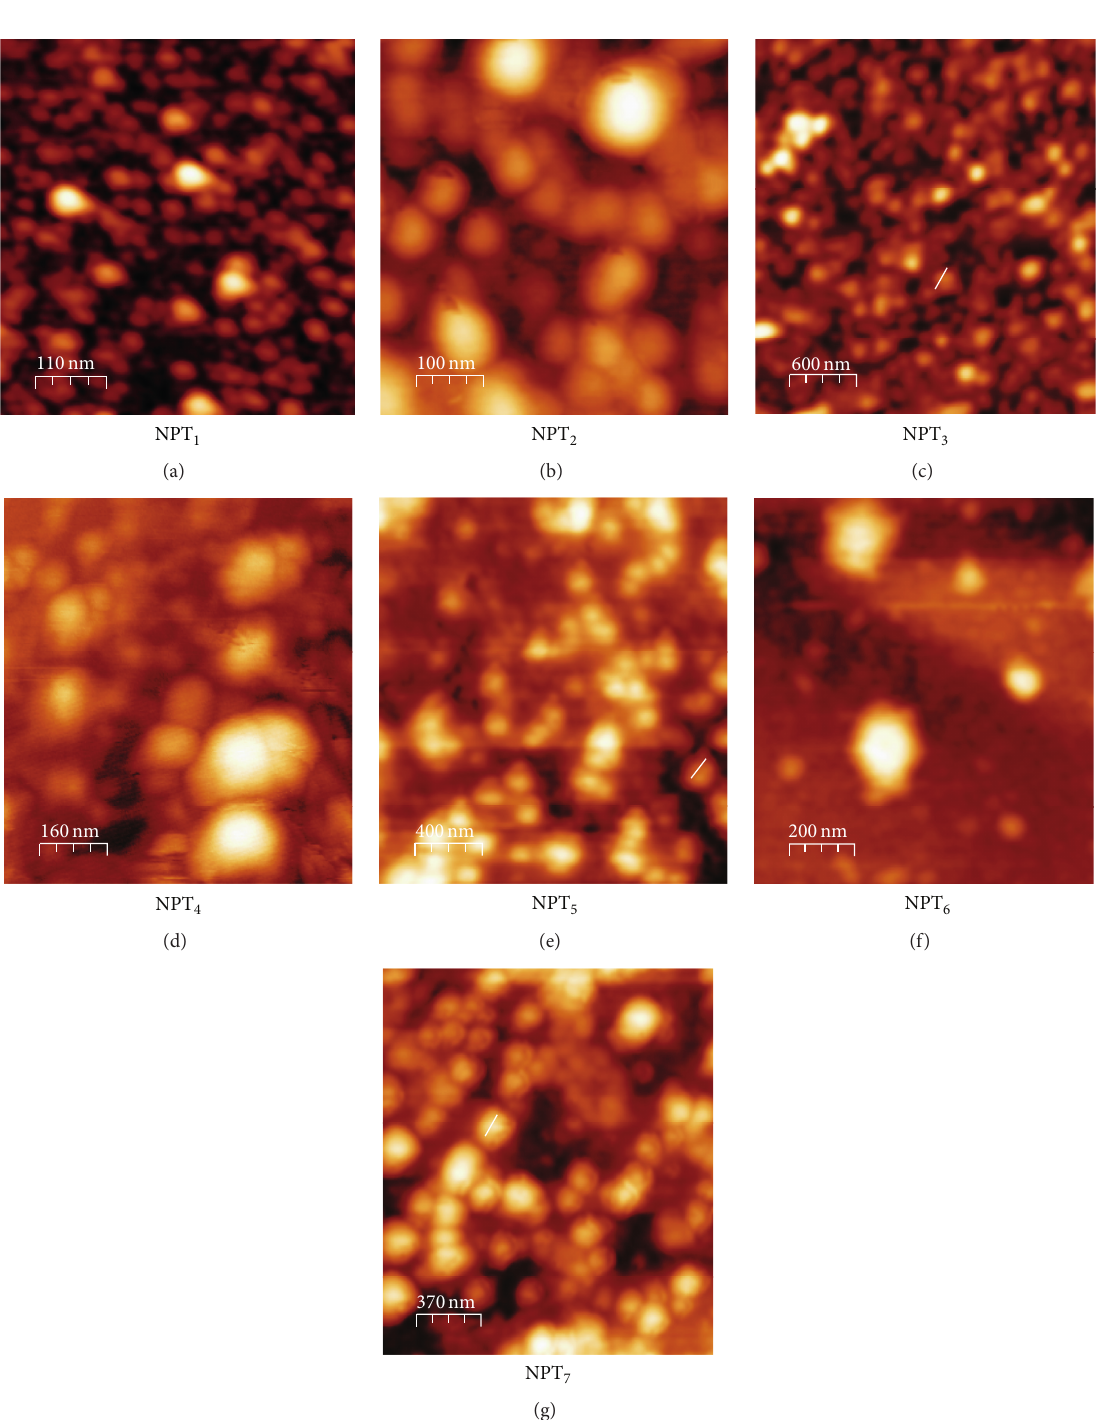
Figure 5: AFM of shape evolution of thiolated chitosan nanoparticles NPT 1 (1: 114), NPT 2 (1: 106), NPT 3 (1:100), NPT 4 (1: 94), NPT 5 (1: 86), NPT 6 (1:77), and NPT 7